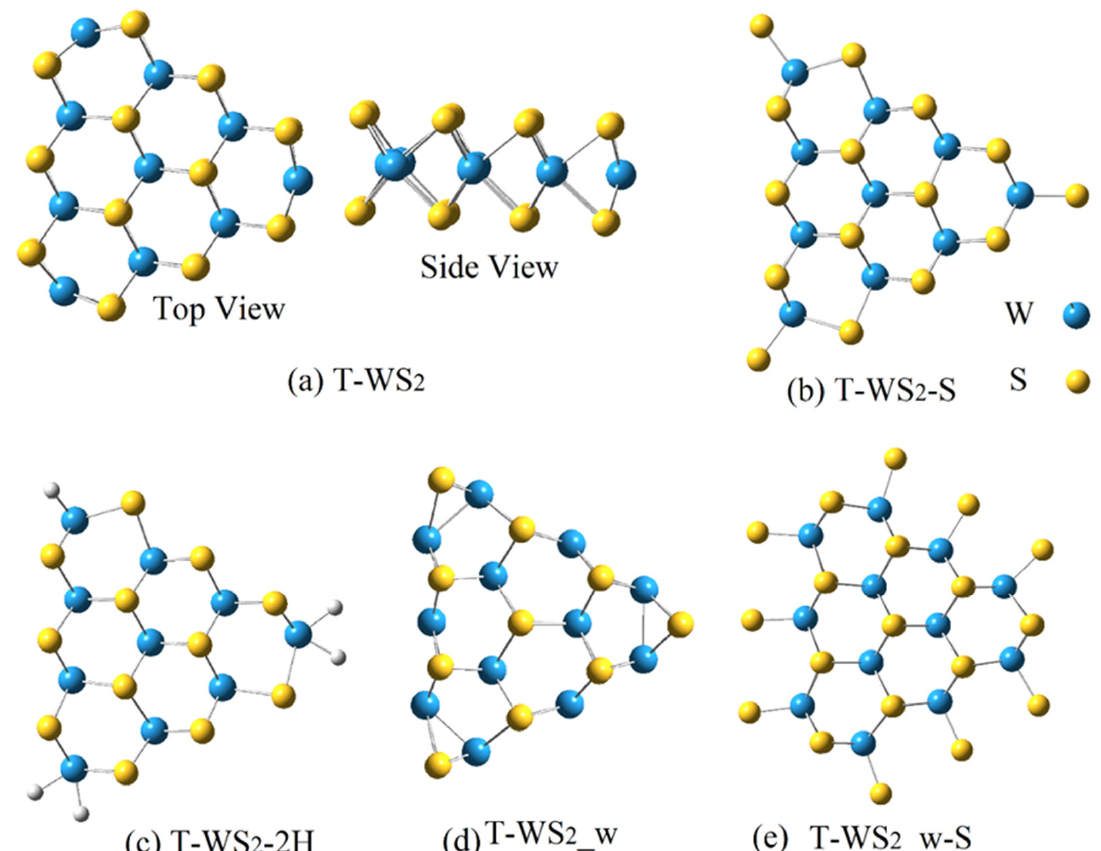
Figure 1. Optimized structures of triangular WS 2 with pristine ( a ), sulfurated ( b ), and double hydrogenated edges ( c ). The structures in ( d , e ) represent pristine and sulfurated WS 2 using another way of building the triangular structure to increase the number of edge Mo atoms.